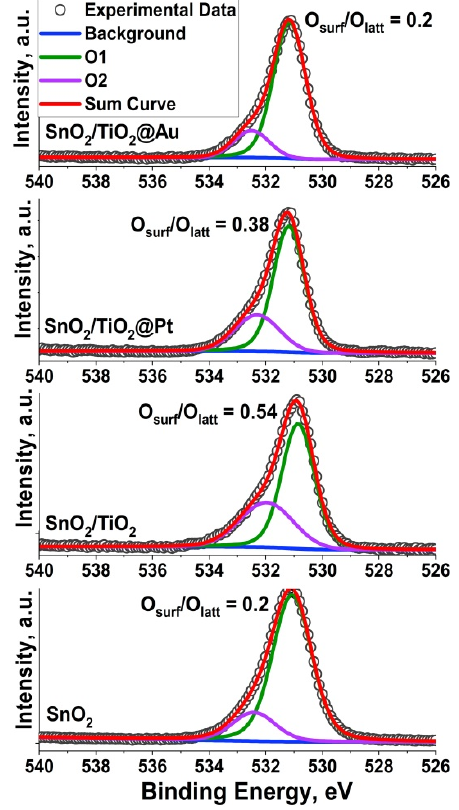
Figure 4. O1s XP-spectra of the synthesized samples. Ti 2p XP-spectra are shown in Figure 5a. The peaks with binding energies of 458.9 and 464.7 eV are ascribed to the Ti 2p 3/2 and 2p 1/2 peaks of Ti(IV), respectively [40]. The binding energy of Ti 2p peak is shifted positively by 0.4 eV both for SnO 2 /TiO 2 @Pt and SnO 2 /TiO 2 @Au samples. It could be assigned to the electron transfer from TiO 2 to Au and Pt NPs, respectively, due to the difference of work function and metal-support in- teractions. [41,42]. The observed situation can also be the reason for the decrease in the O surf /O lat ratio for the SnO 2 /TiO 2 @Pt and SnO 2 /TiO 2 @Au samples (Figure 4).